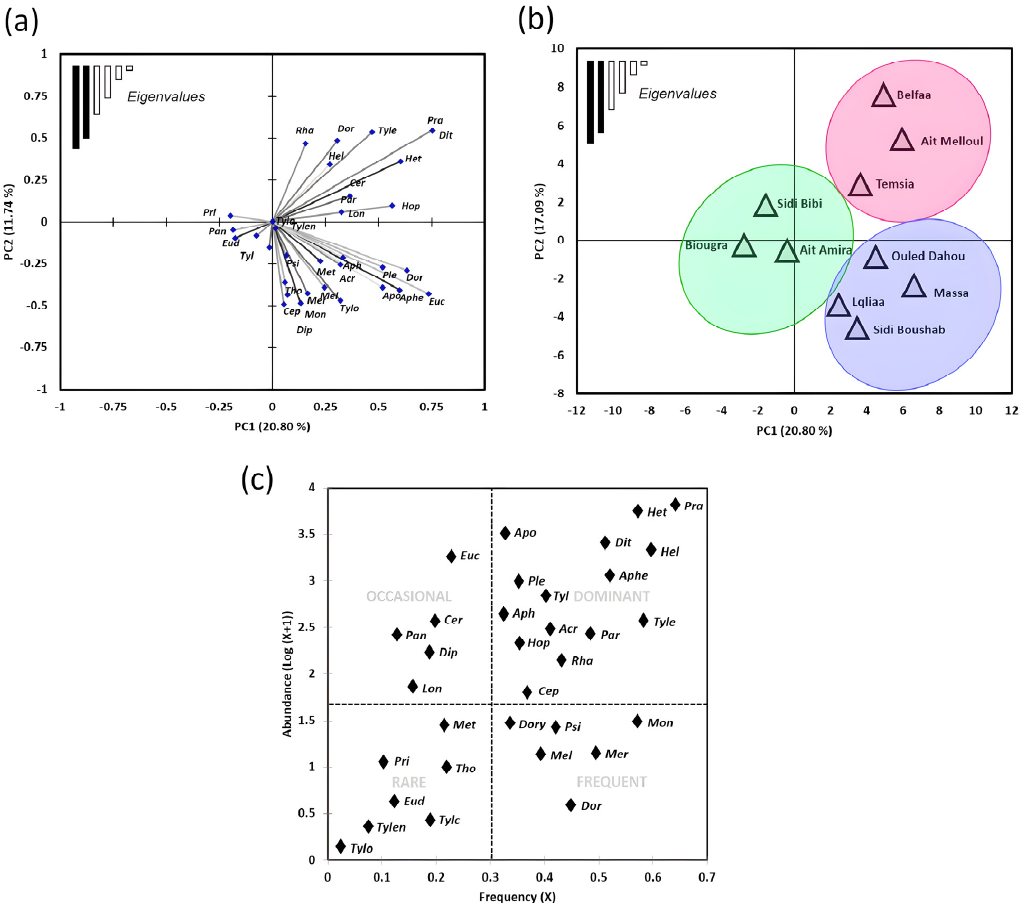
Figure 3. Nematode community patterns and distribution in sampled wheat fields of Southern Morocco. ( a ) Principal component analysis (PCA) (Kendall type) depicting nematode distribution patterns. ( b ) PCA of nematode distribution according to the different surveyed localities. ( c ) Distribution diagram (abundance–frequency) of nematode communities.